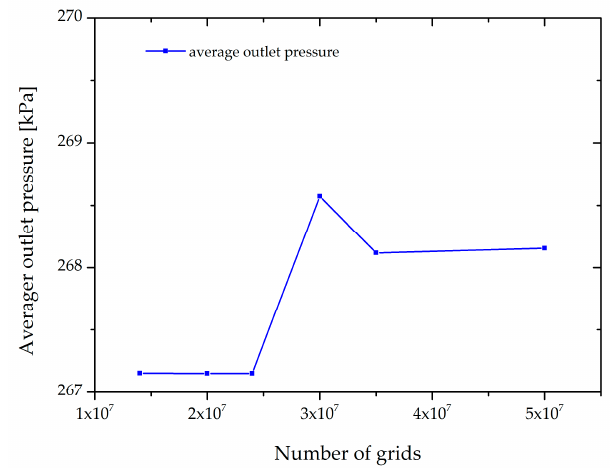
Figure 7. The grid dependency test.